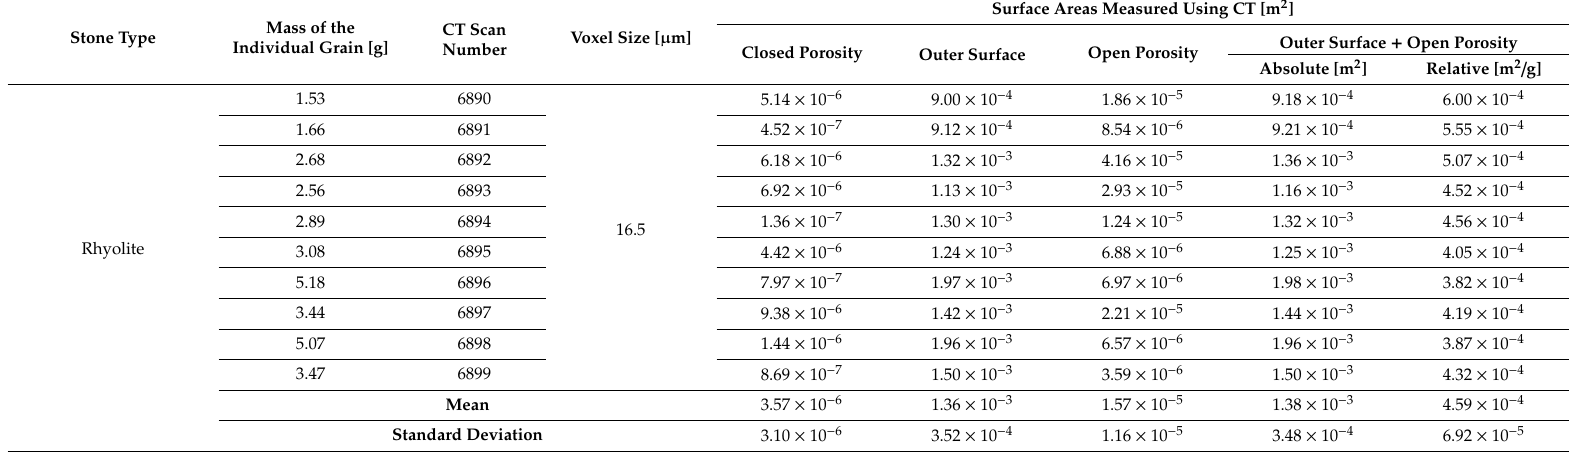
Table A3. Individual grain results from the cracking analysis of stone category GK3 (quarried stone; alkali sensitivity EI-S). Stone Type